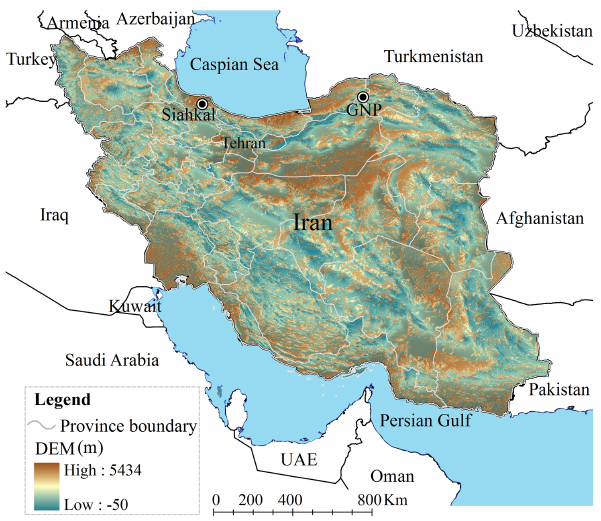
Figure 1. Location of the Siahkal forest area and Golestan National Park (GNP) in northern Iran.